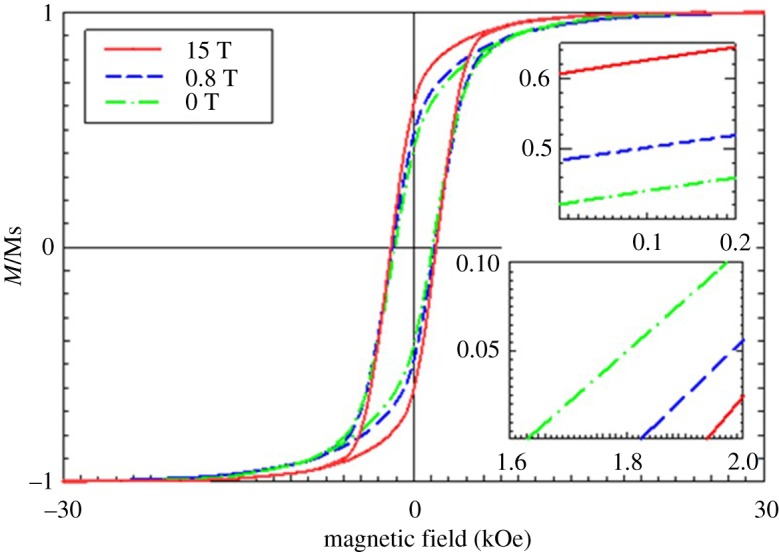
Magnetic characterization of dispersed spindle α″-Fe16N2/Al2O3 MNPs and their assembled arrays under EMFs of 0.8 and 15 T with the measured magnetic field applied parallel to arrays.